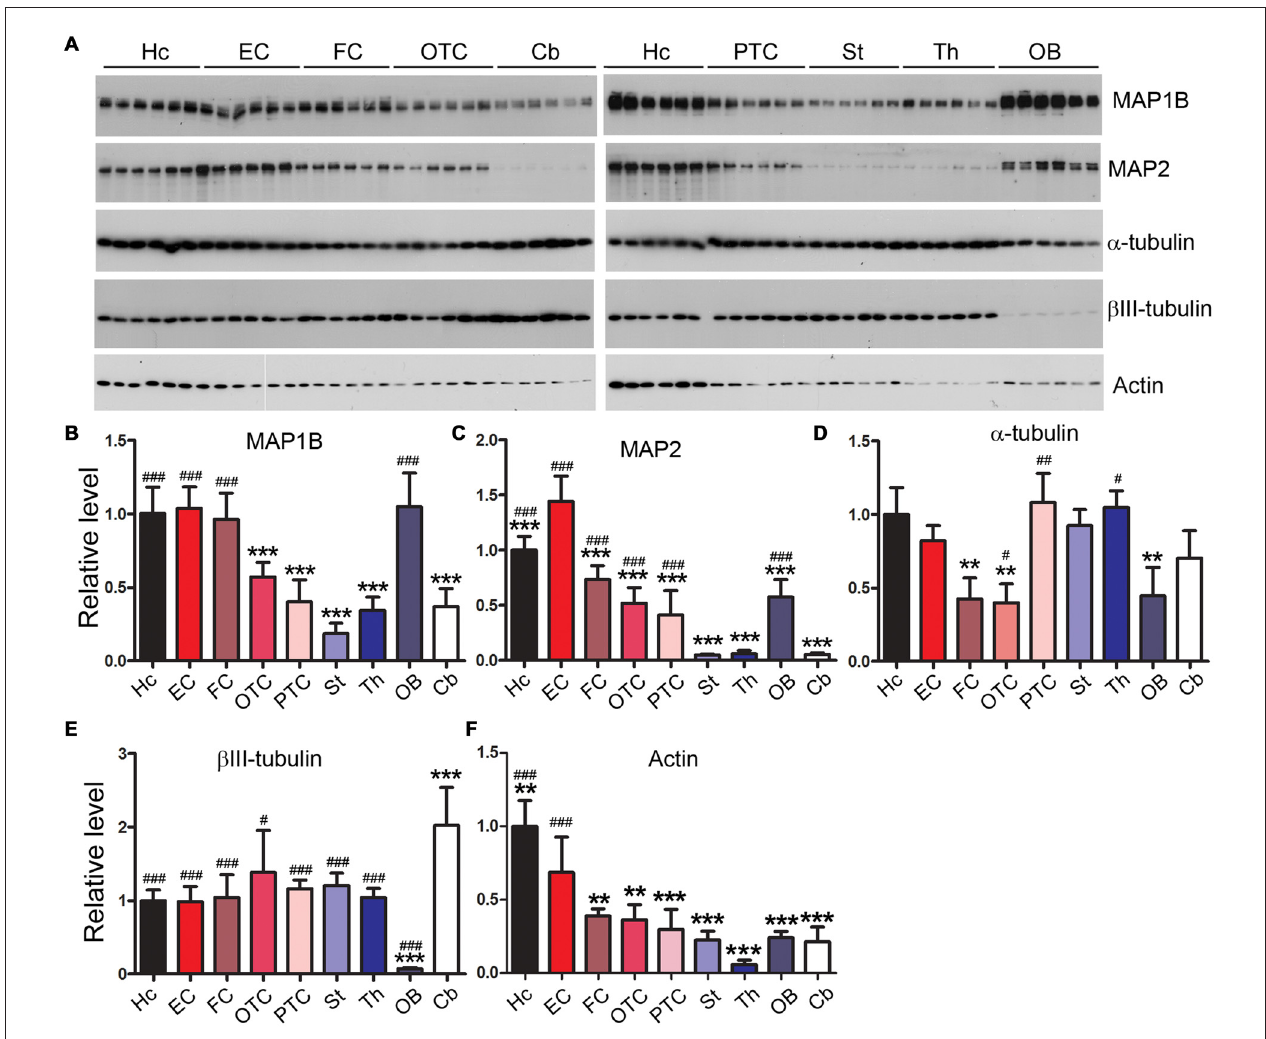
FIGURE 5 | Differential expression profiles of microtubule-related proteins in various rat brain regions. Western blots (A) were employed to determine the levels of MAP1B (B) , MAP2 (C) , α -tubulin (D) , β III-tubulin (E) and actin (F) in nine brain regions. Data are expressed as mean ± SD, which represents matched observations of individual brain regions in six rats. ∗ Compared to EC; # compared to cerebellum. # P < 0.05; ∗∗ , ## P < 0.01; ∗∗∗ , ### P <